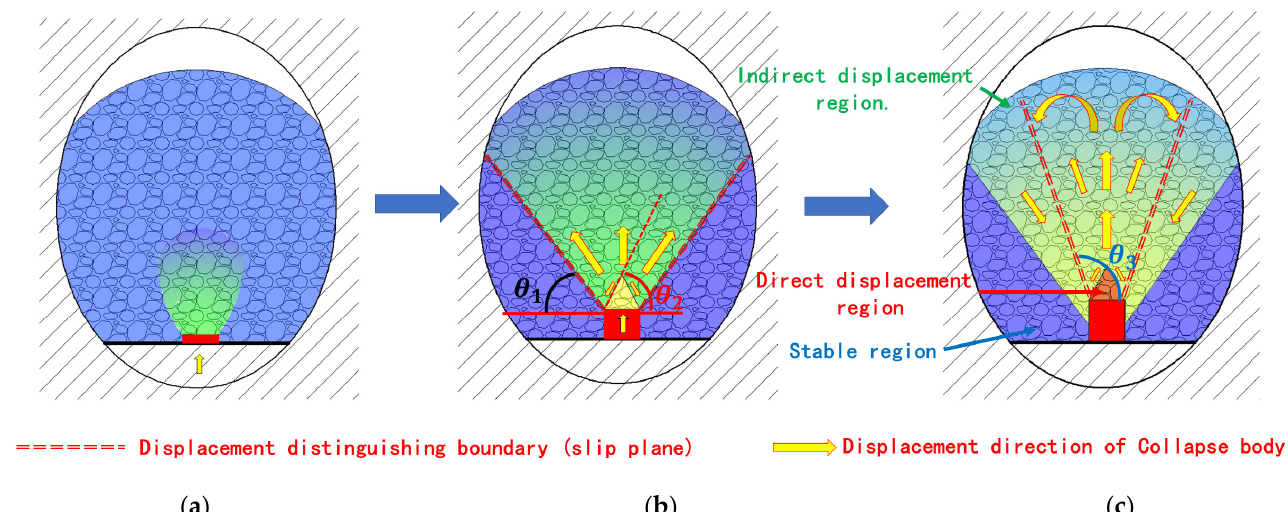
Figure 7. Schematic diagram of the displacement of the collapse body in the channel expansion process: ( a ) the initial start-up stage; ( b ) the uplift stage; ( c ) the collapse stage.